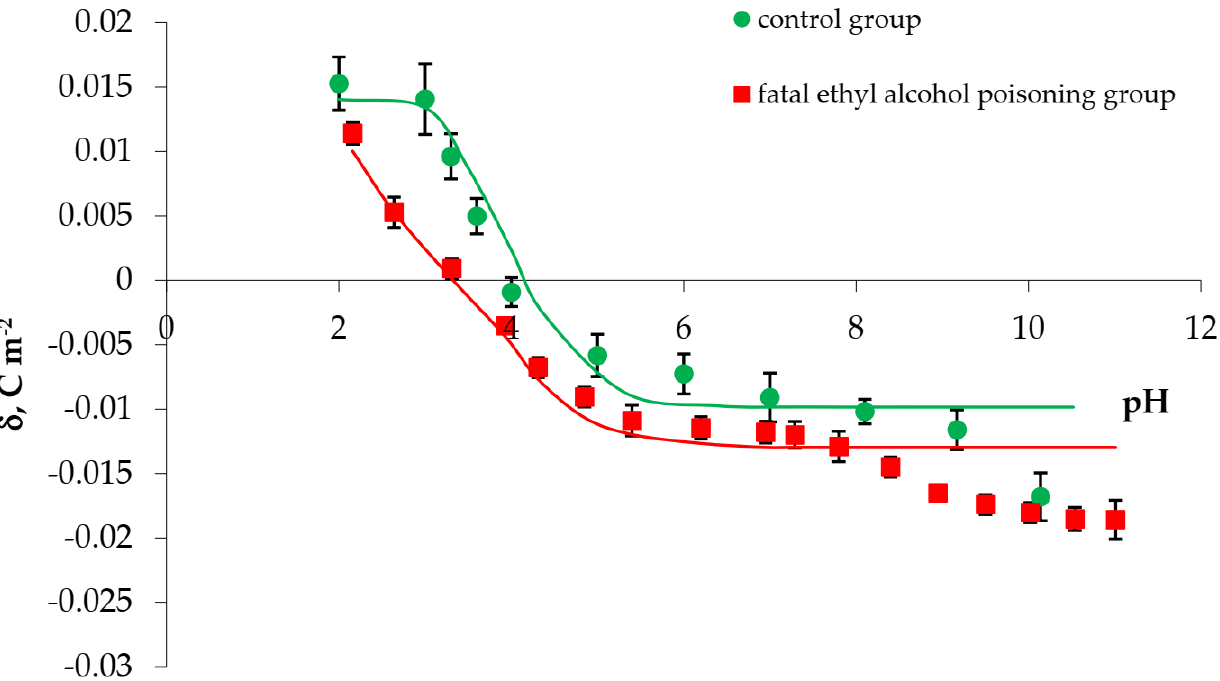
Figure 4. A comparison of experimental and theoretical surface charge density values of thrombocytes vs. pH of the electrolyte solution: • control, (cid:4) fatal ethyl alcohol poisoning. Points represent the experimental values and curves represent theoretical